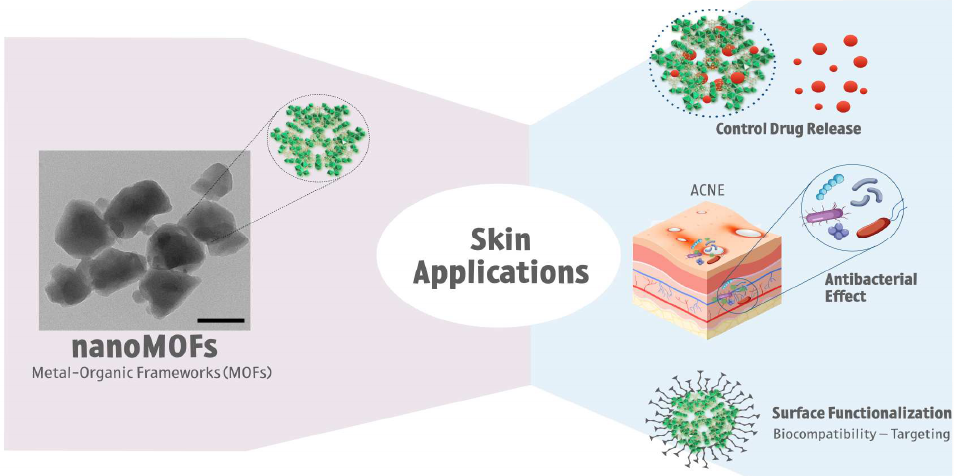
Figure 3. Morphological structure of MIL100 metal-organic frameworks (MOFs) acquired by elec- tronic transmission microscopy (TEM), and some schematic representations of MOFs applications on the skin.